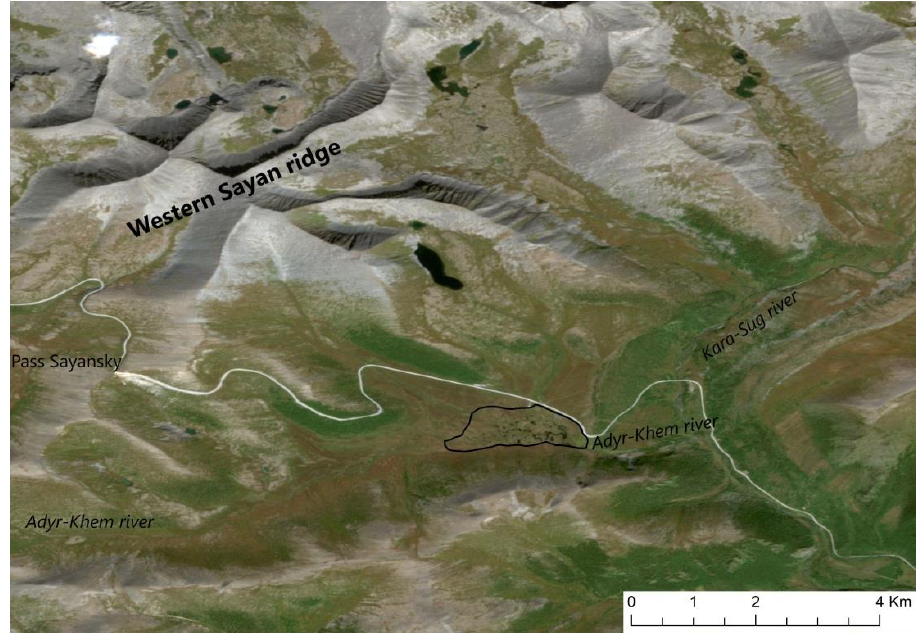
Figure 2. The key site (palsa mire) marked with black bound in Adyr-Khem river valley (on topo- graphic map and satellite image Sentinel-2B, shooting date 27 August 2019). Coordinates of the boundaries of the key site: the westernmost point 89.9357 51.6917; the easternmost point 89.9543 51.6914; the northernmost point 89.9468 51.6964; southernmost point 89.9418 51.6902.